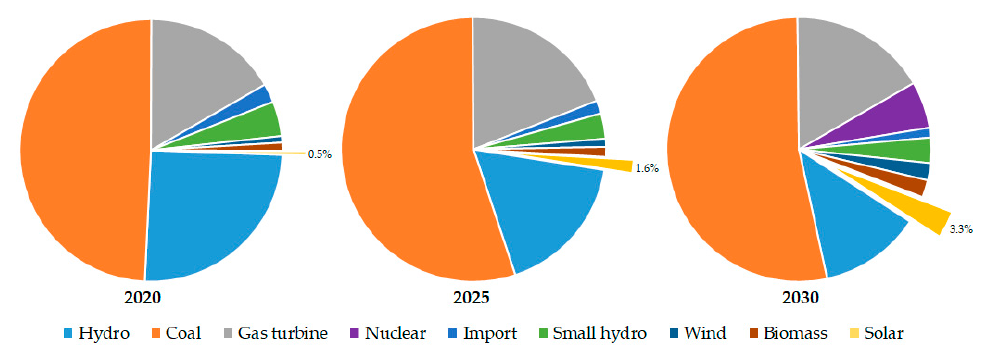
Figure 11. Share of Electricity production by fuel under PDP7 rev.